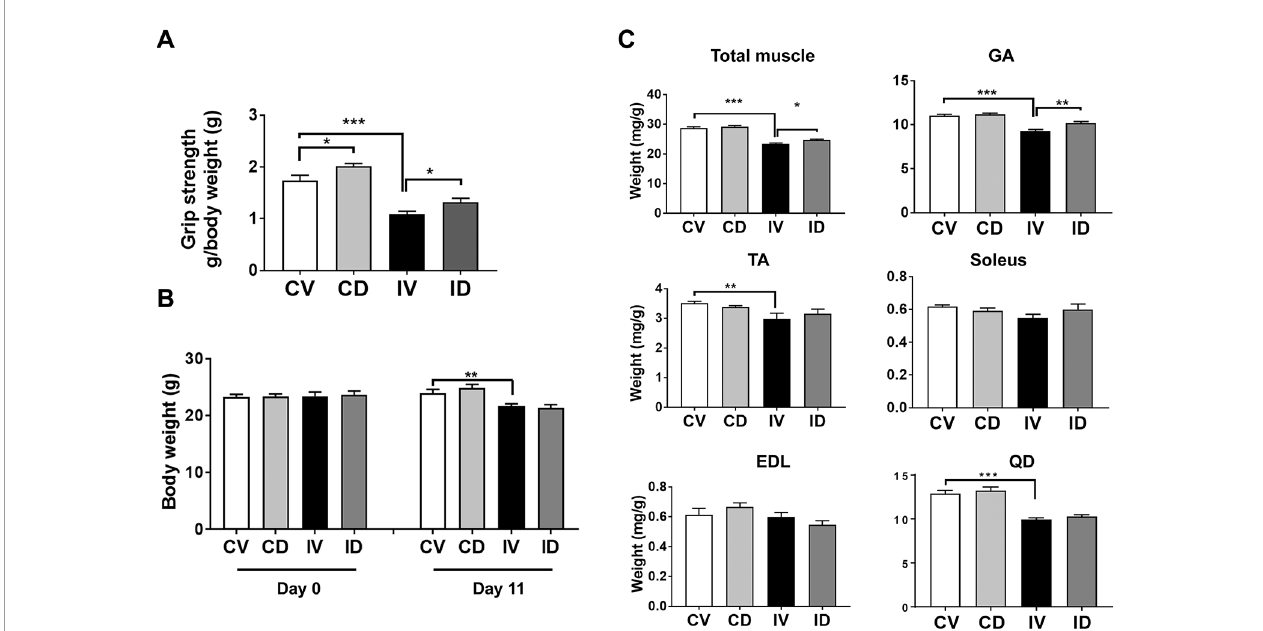
FIGURE 1 | Dulaglutide improved muscle strength and attenuated muscle loss in disuse condition. Ten-week-old C57BL/6 male mice were subjected to spiral wire immobilization for 4 d and administrated dulaglutide (Trulicity, 600 µg/kg, subscutaneous). Mice were maintained for additional 7 d. (A) Grip strength was measured on day 11 and grip strength value was normalized to fi nal body weight. (B) Body weights on day 0 and 11 were recorded. (C) The total muscle weight and weight of various muscle types, including gastrocnemius (GA), soleus, tibialis anterior (TA), extensor digitorum longus (EDL), and quadriceps (QD), were measured right after sacri fi ce and normalized to the fi nal body weight. Data are shown as means ± S.E.M, n = 6 – 7/group; *p < 0.05, **p < 0.01, ***p < 0.001. CV, control + vehicle; CD, control + dulaglutide; IV, immobilization + vehicle, ID; immobilization +